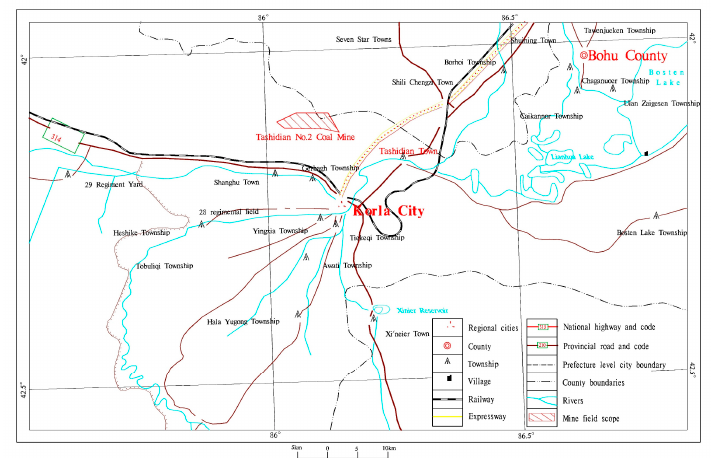
Figure 1. Illustration of the traffic position of the research area.